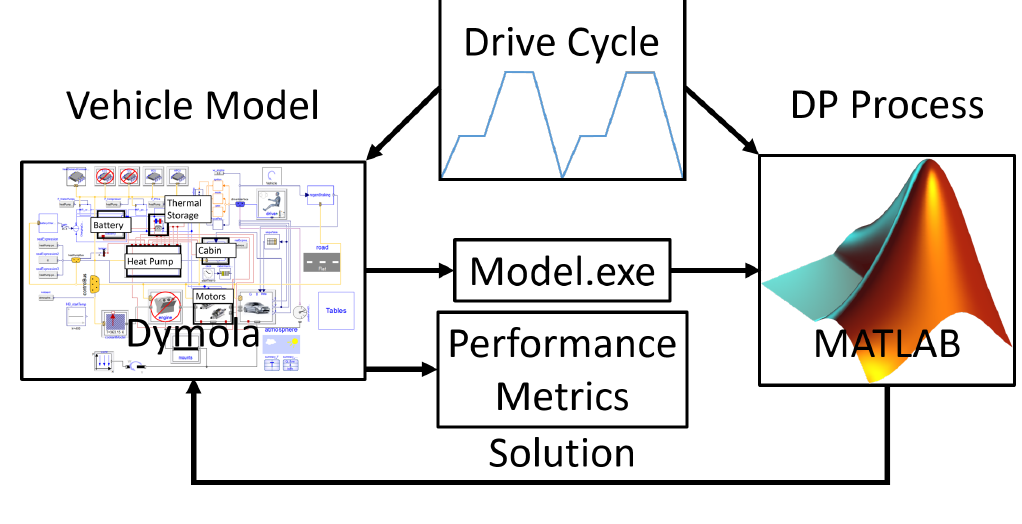
Figure 13. Simulation set up, with model generated in Dymola shown in ( a ) and its incorporation into the dynamic programming (DP) set up shown in ( b